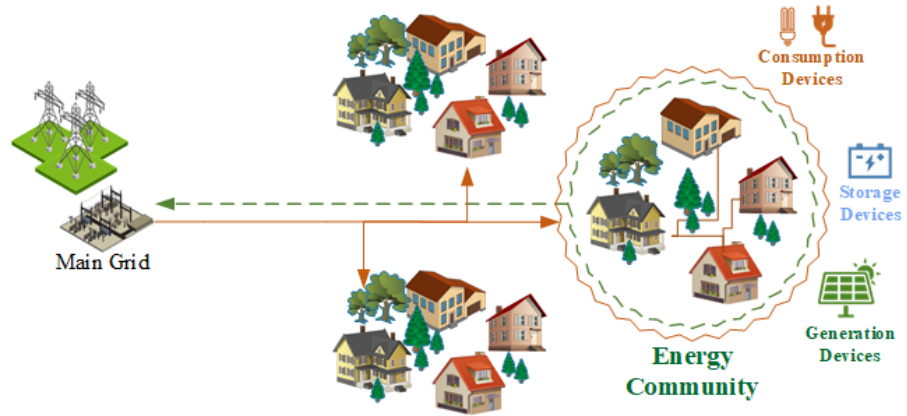
Figure 1. Energy community scheme.